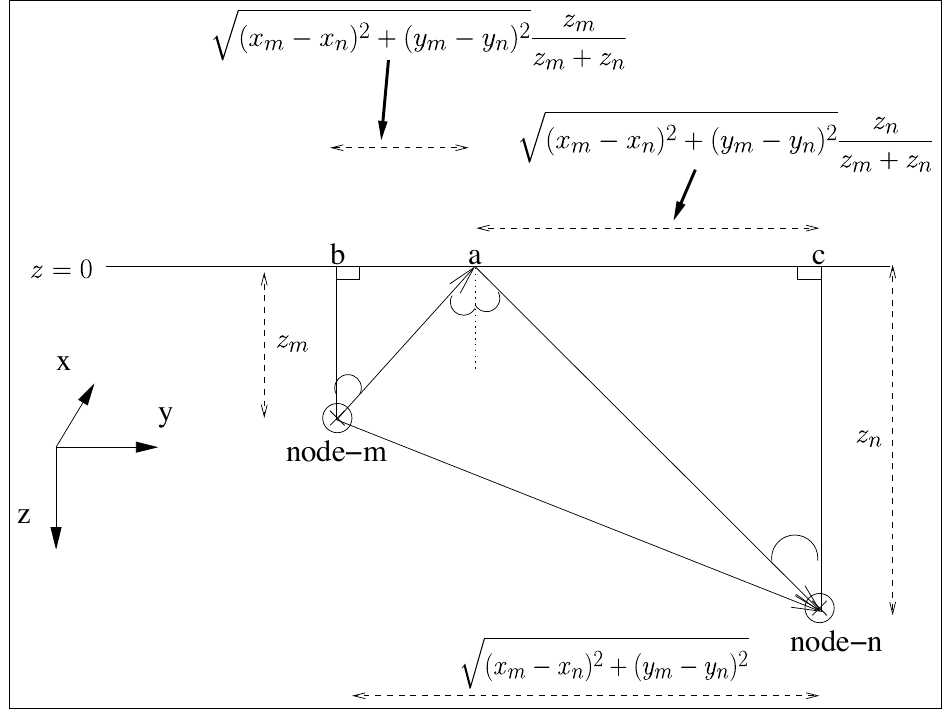
Figure 1. Soil-node to soil-node communication between nodes m and n : direct vs. reflected